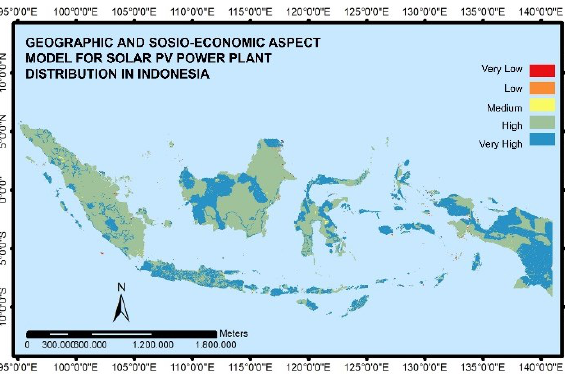
Figure 2 . Geographic and Socio-Economic aspect Model